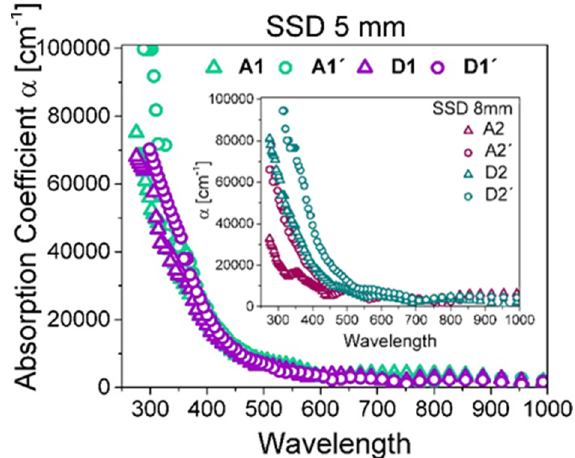
Figure 3. The absorption coefficients of the SiO x films without (A1, A2, D1, D2) and with